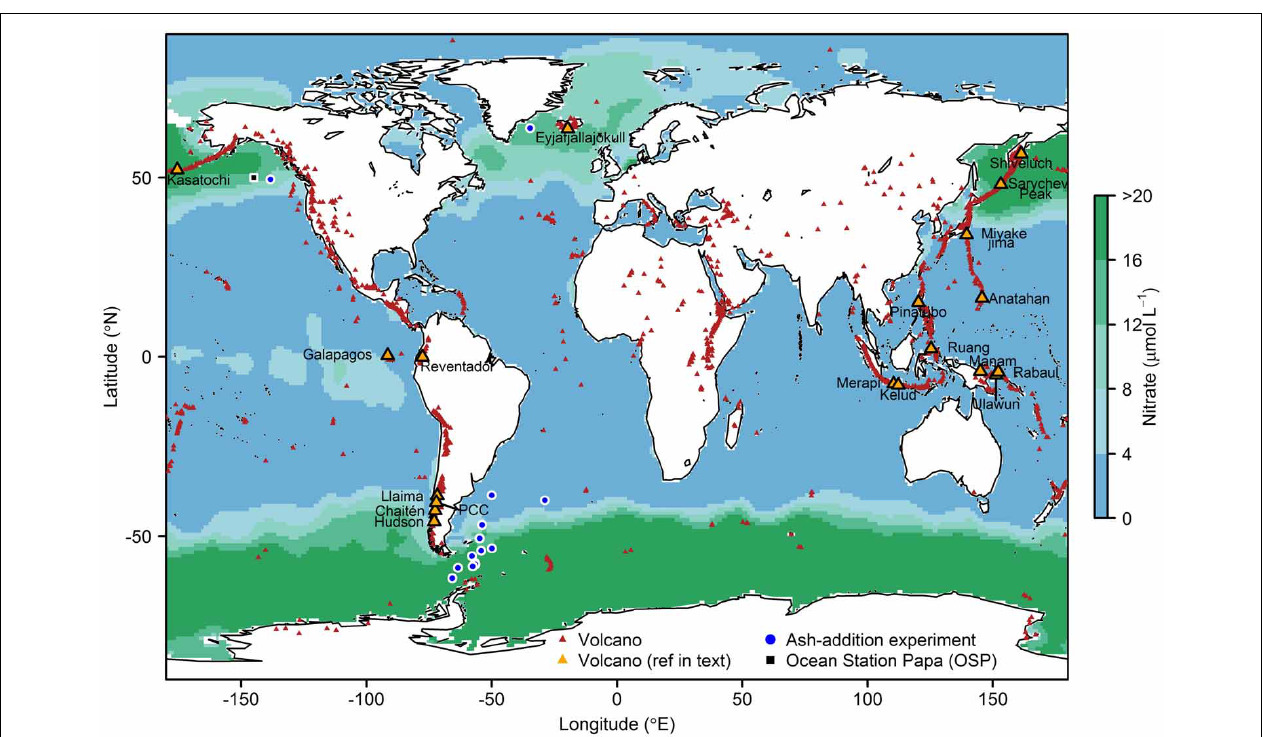
FIGURE 1 | Global surface ocean nitrate concentrations from the World Ocean Circulation Experiment (WOCE). Red triangles show the locations of volcanoes thought to have been active in the last 10,000 years (Global Volcanism Program, http://www . volcano . si . edu/ index . cfm), orange triangles = those referred to in the main text and Table 3 . The Sierra Negra and La Cumbre volcanoes referred to in